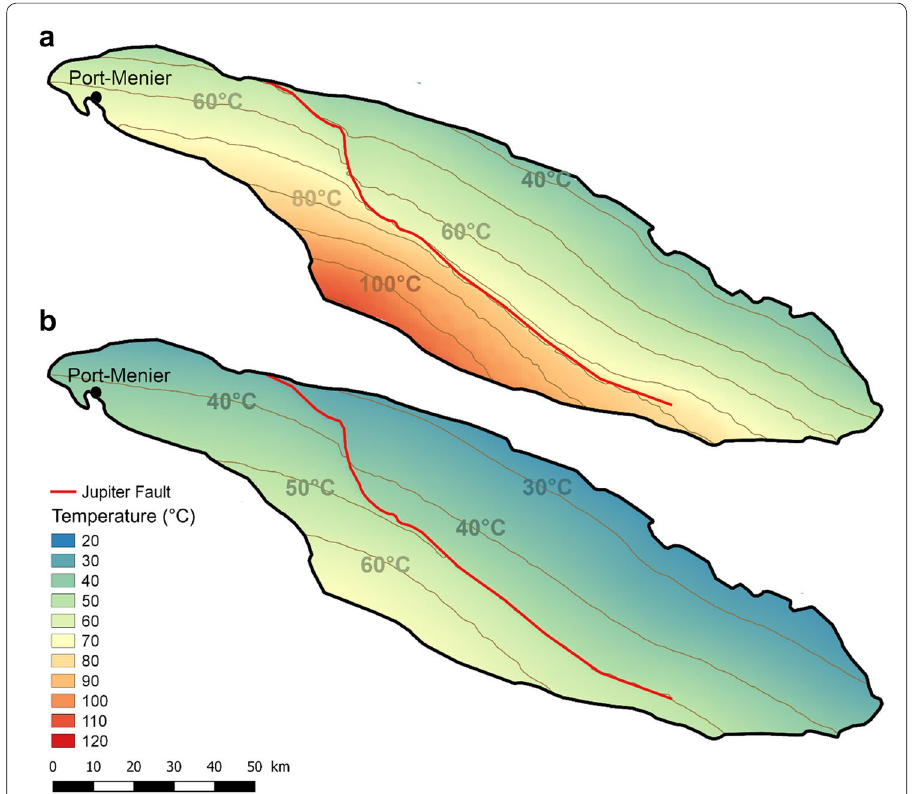
Fig. 16 Temperature simulated at the base of the sedimentary basin (base of the Romaine thermal unit) for a the optimistic and b the pessimistic